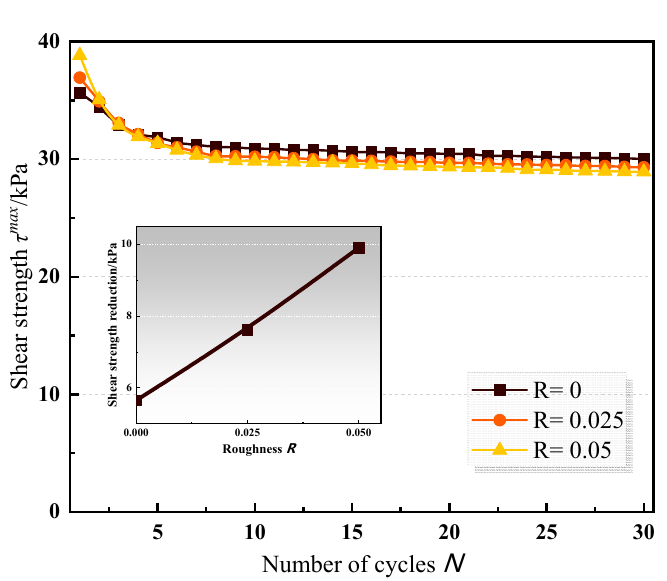
Figure 12. Shear strength–number of cycles curve under different roughness levels.